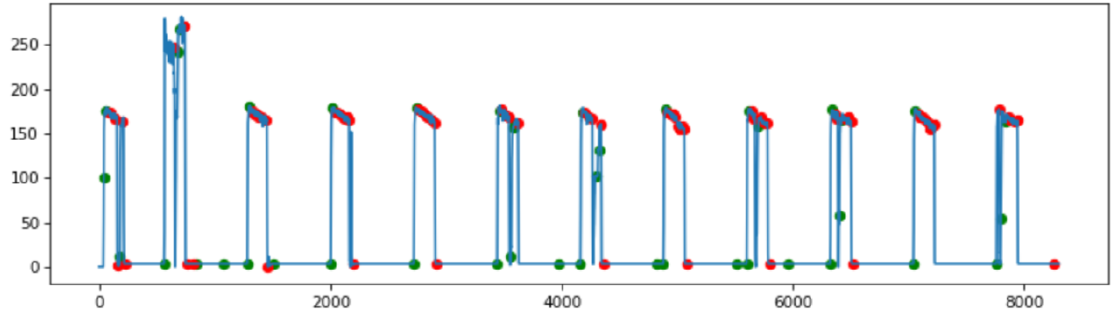
Figure 4. Performance changes identification by t -test.